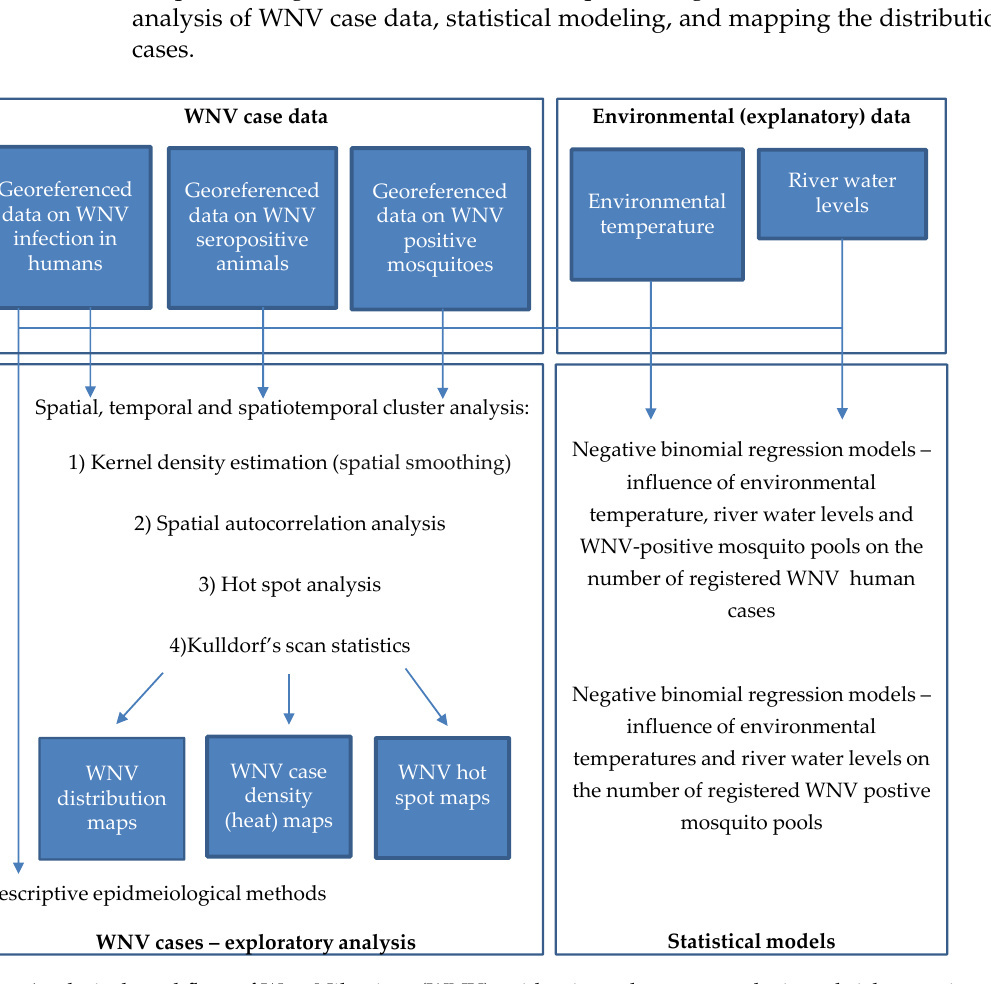
Figure 1. Analytical workflow of West Nile virus (WNV) epidemic explanatory analysis and risk mapping. Cases of WNV infection and climatological factors in South Banat District, were anal- ysed using ESRI’s ArcGIS 10.5 software (ESRI Geographic information system